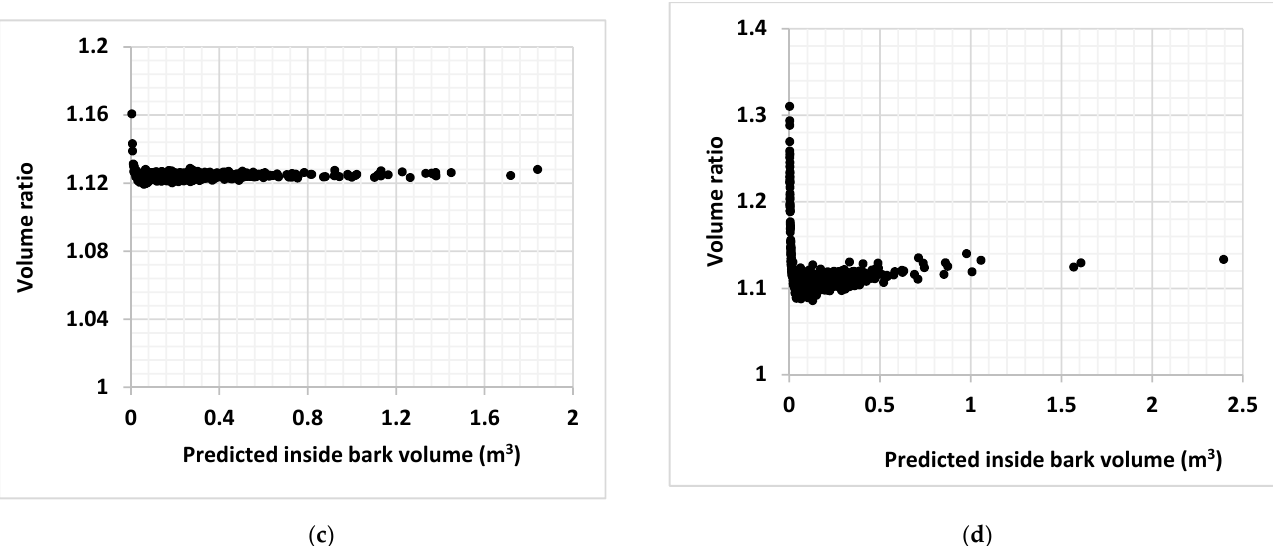
Figure 1. Scatterplots of the ratio of outside bark to inside bark volumes estimated using Equation (10) against inside bark volumes for ( a ) jack pine, ( b ) black spruce, ( c ) balsam fir, and ( d ) sugar maple. Estimated inside and outside bark volumes were also plotted against their observed counterparts for all tree species. Estimated volumes were randomly clustered around the 1:1 line for both inside (Figure 2) and outside bark (Figure 3) volumes for all tree species. Example plots are included for jack pine, black spruce, balsam fir, and sugar maple representing pine, spruce, fir, and other hardwood species, respectively.